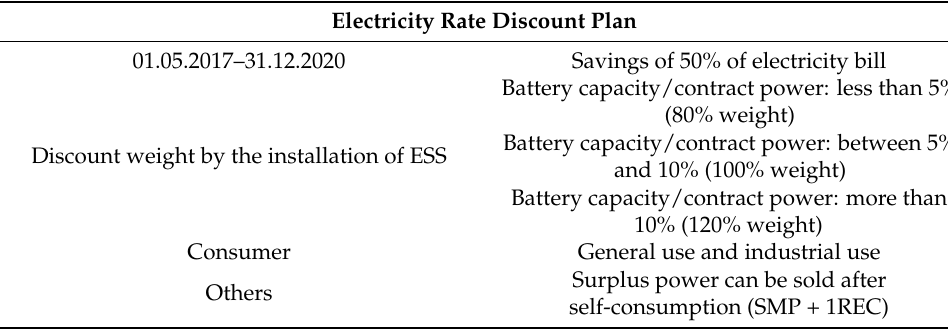
Table 4. Electricity rate discount plan for renewable energy users [30].